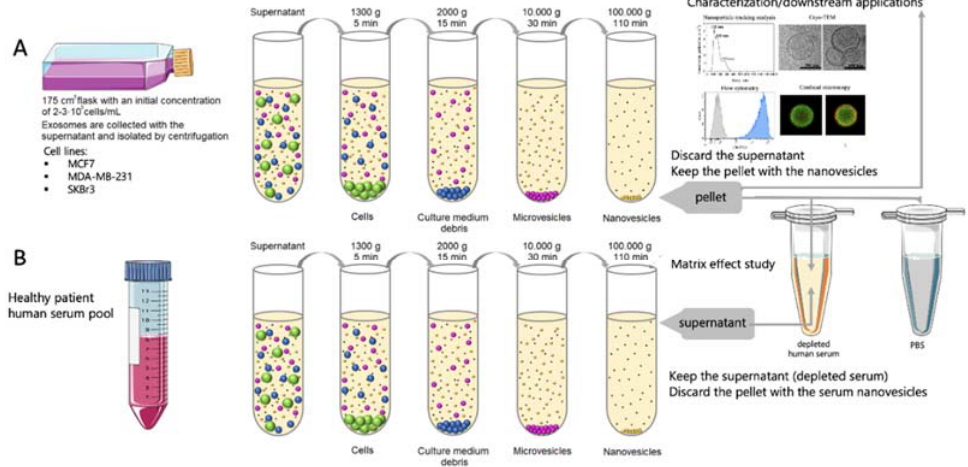
Figure 1. ( A ) Schematic procedure for the isolation of exosomes from cell culture supernatant of breast cancer cells. ( B ) Schematic procedure for the obtaining of depleted human serum. The